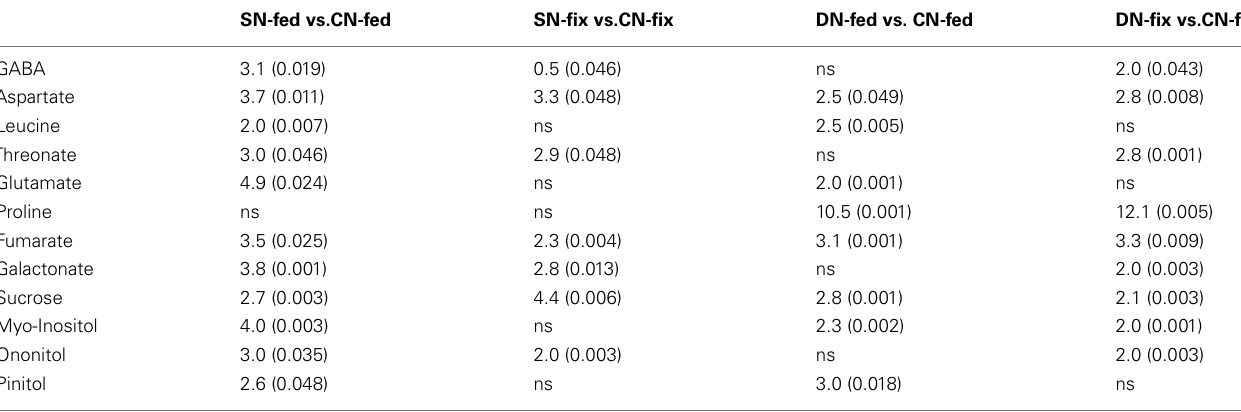
Table 2 | Ratios of stress responsive root metabolites